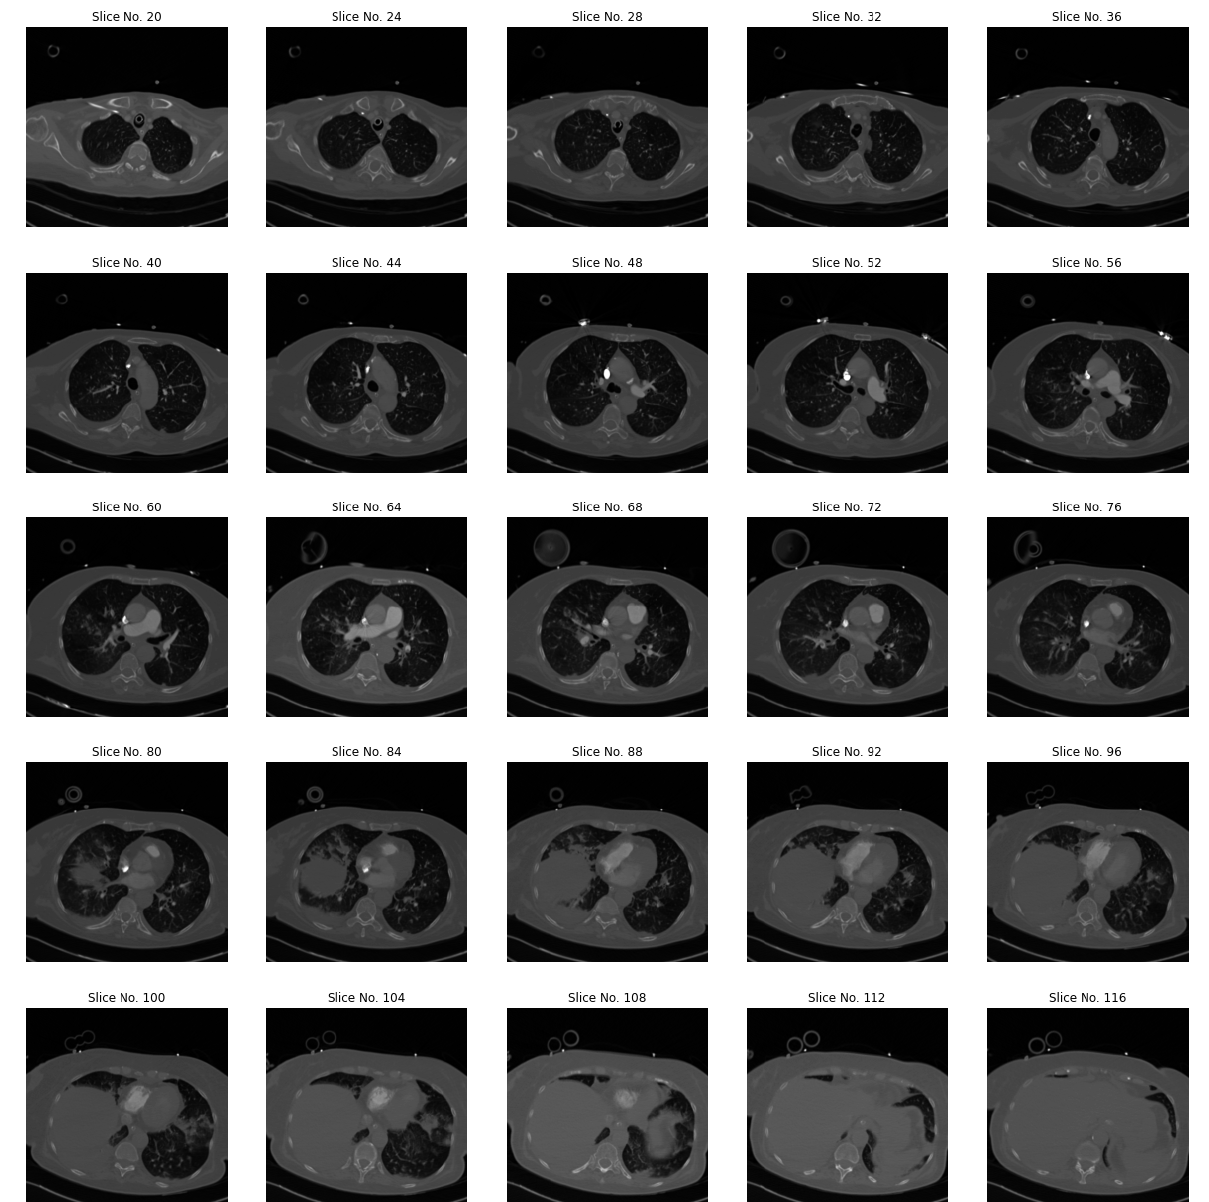
Figure 1. Sample CT images of a randomly chosen subject from the